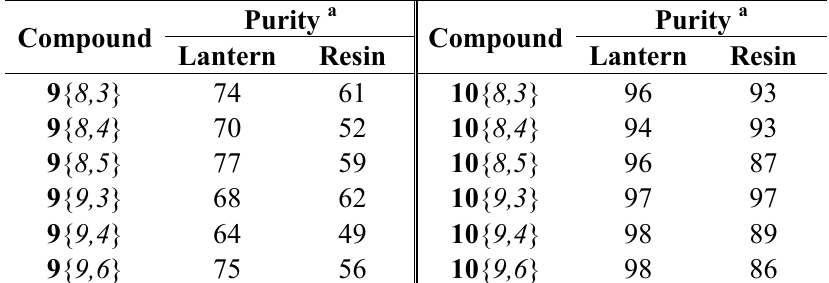
Table 1. Comparison of the analytical data for selected library members obtained from either resin or